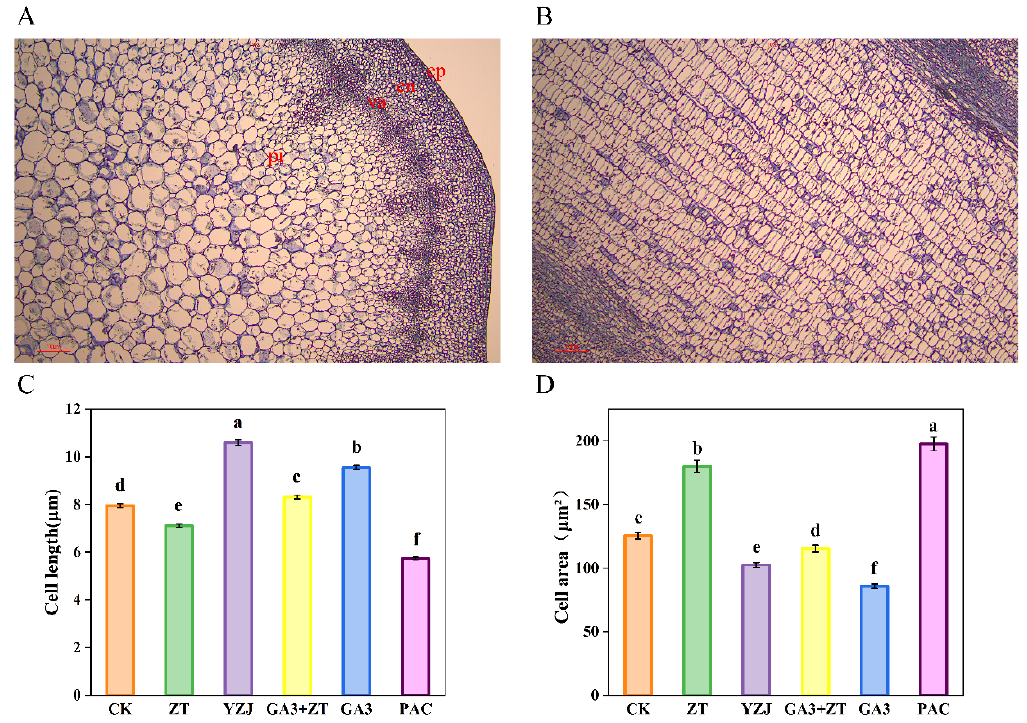
Figure 2. Histological analysis of shoot apices in hormones-treated flowering Chinese cabbage at bud emergence stages. ( A , B ) Microscopic images of transverse and longitudinal sections of shoot apices: ep, epidermis; en, endodermis; va, vascular bundle; pi, pith cells. ( C ) Length of pith cells in longitudinal sections of shoot apices. ( D ) Cell area of pith cell in transverse sections of shoot apices. Statistically significant differences in mean values at different sampling points are indicated by different letters (Duncan’s test, p < 0.05). Bars are SE ( n = 4).